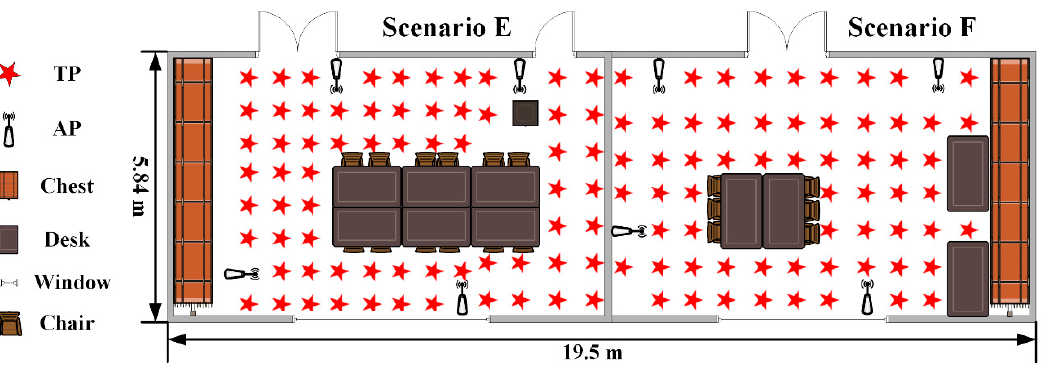
Figure 6. The presentation of the layout of the experimental area.